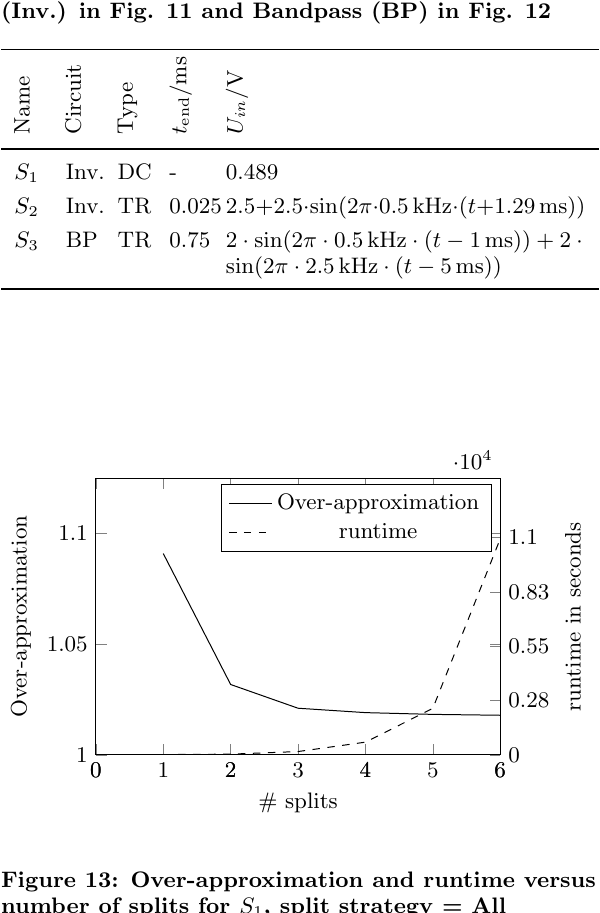
Figure 13: Over-approximation and runtime versus number of splits for S 1 , split strategy =